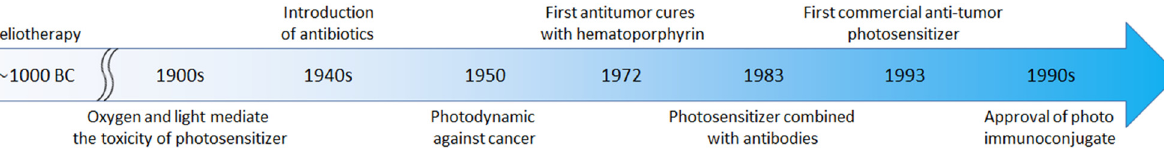
Figure 1: Historical development of photodynamic therapy.